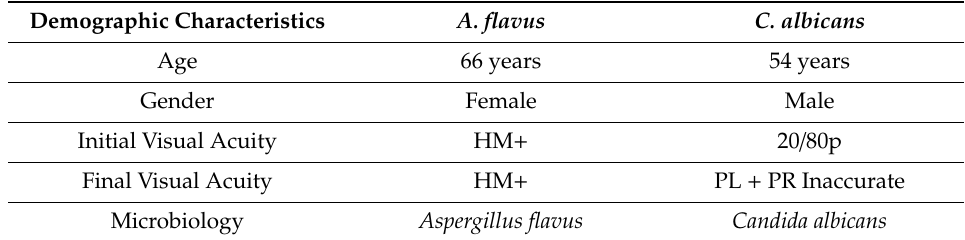
Table 1. Clinical and Demographic details of the patients diagnosed clinically with fungal